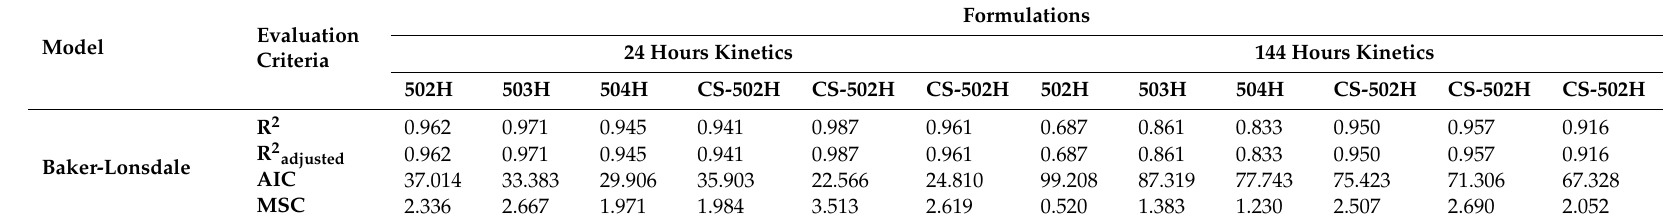
Table 5. Kinetic results for Baker-Lonsdale